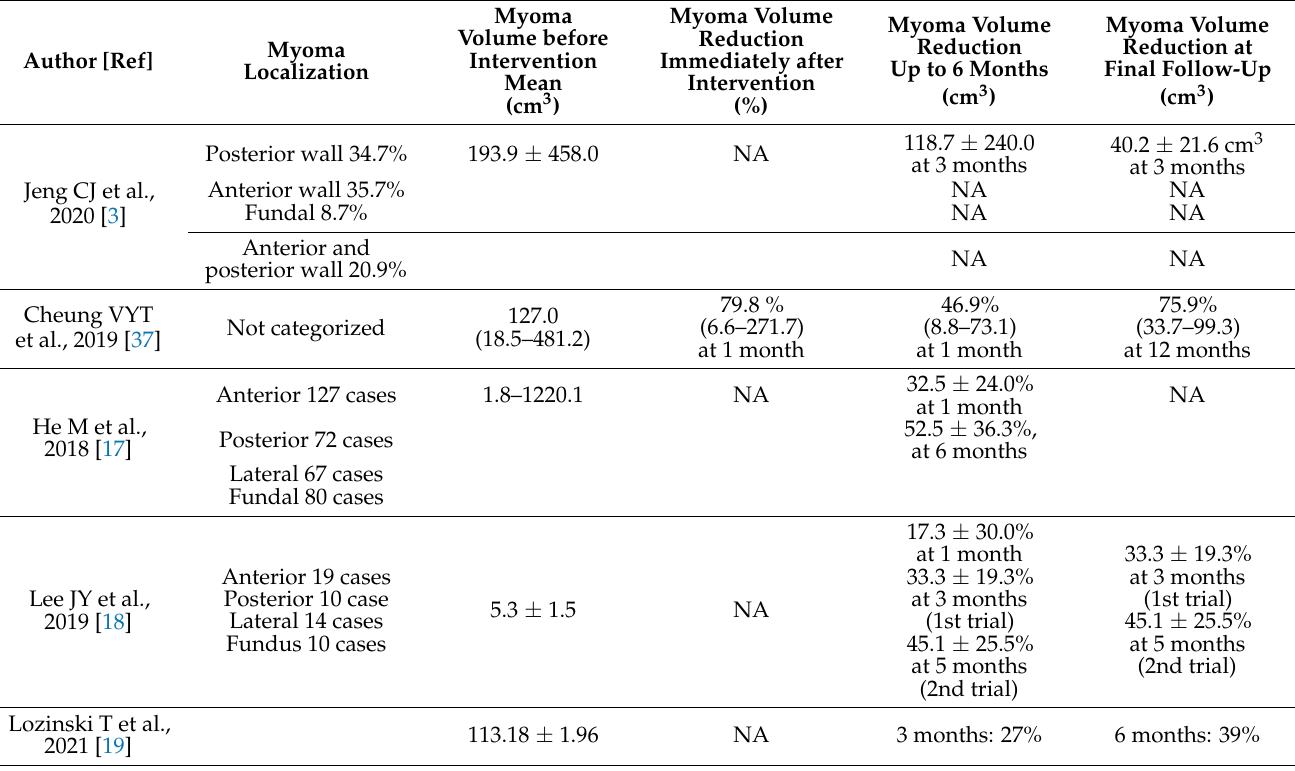
Table 6. Myoma volume reduction after